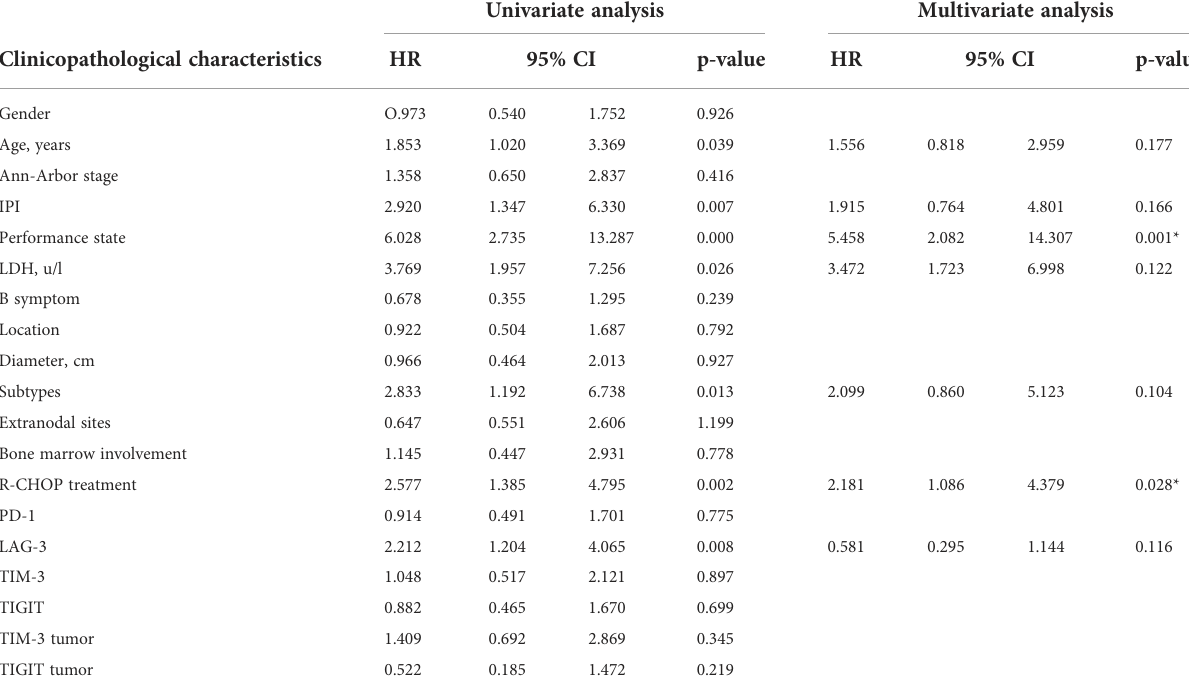
TABLE 5 Univariate and multivariate analyses of clinicopathological factors associated with overall survival in DLBCL patients. Univariate analysis Multivariate